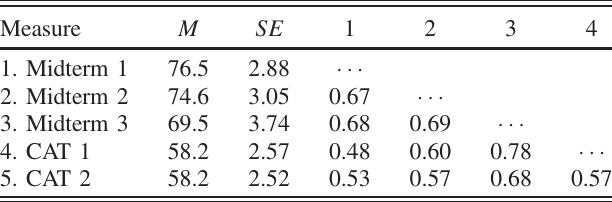
TABLE I. Means, standard errors of the mean, and intercorre- lations for scores on exams and CATs. Note that N ¼ 34 and that all correlations are significant at p < 0 . 005 .